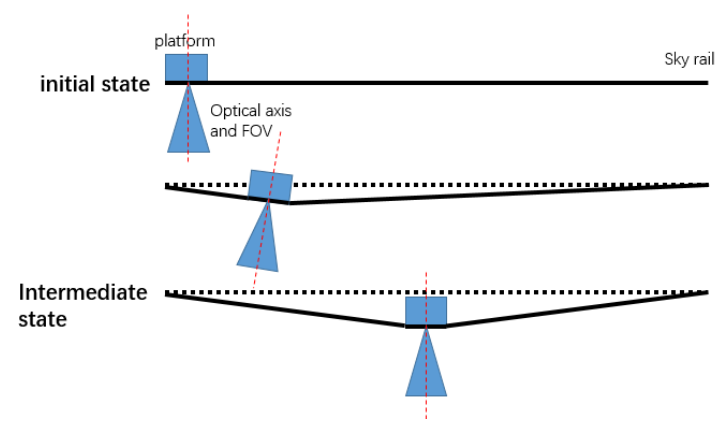
Figure 26. Operating status analysis of the experimental equipment.